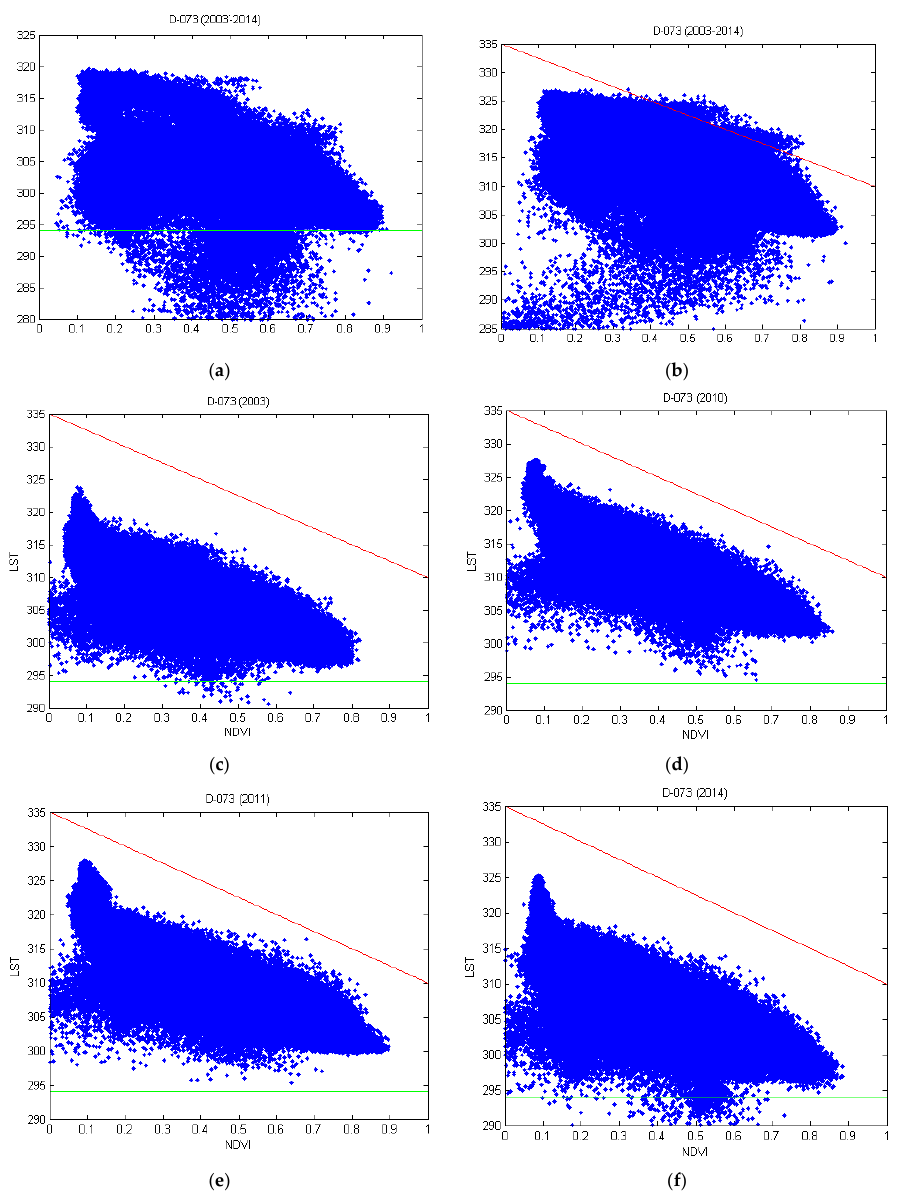
Figure 3. Plots of LST-NDVI in the first 16 days of March (D-073), spanning 2003–2014 for ( a ) the determination of the cold edge using the multiyear maximum-value NDVI products and maximum– minimum-value composite LST products, ( b ) the determination of the warm edge, using the multiyear maximum-value composite LST and NDVI products, and the determination of the warm and cold edges, using the single-year maximum-value composite LST and NDVI products at D-073 during the years ( c ) 2003, ( d ) 2010, ( e ) 2011, and ( f ) 2014, plotting the single-year maximum-value composite LST and NDVI products in the first 16 days of March for the certain periods to determine the multiyear (2003–2014) and single-year (2003, 2010, 2011, and 2014) warm and cold edges,